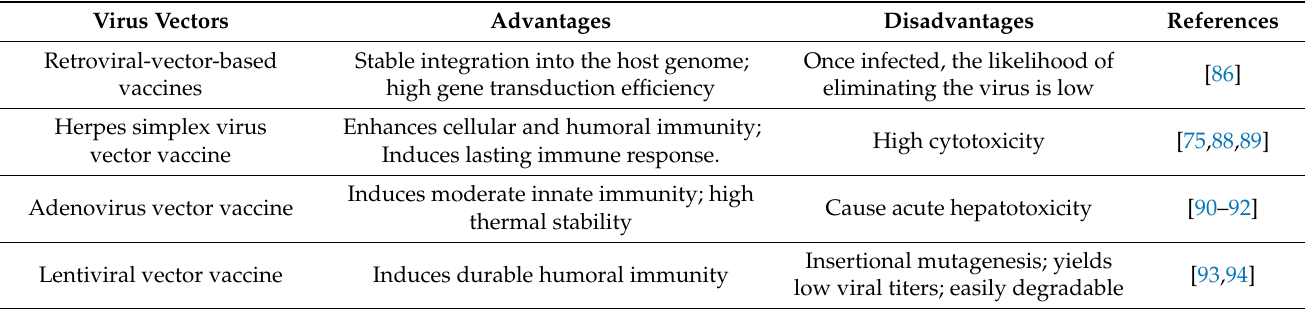
Table 3. Viral vectors and their advantages and